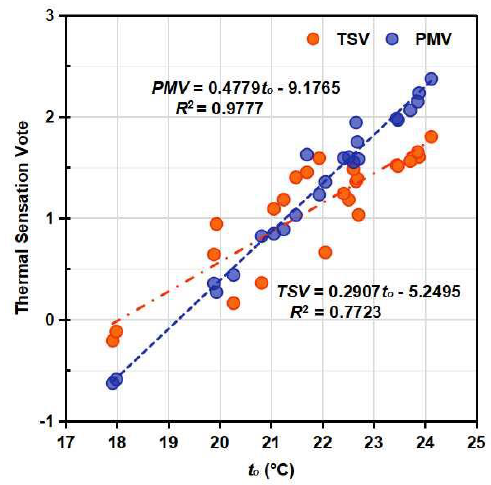
Figure 11. Regression relationship between the indoor temperature and the thermal sensing voting (TSV) and the predicted mean vote (PMV).